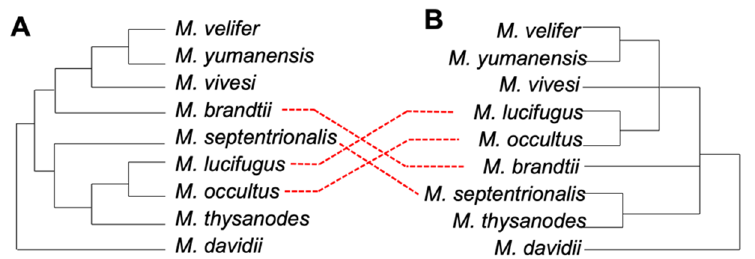
Figure 1. A simplified version of recent mitochondrial ( A ) and nuclear ( B ) phylogenetic trees for the genus Myotis . The trees were constructed using whole mitogenomes and 3648 nuclear UCEs. Adapted from [15] with permission.